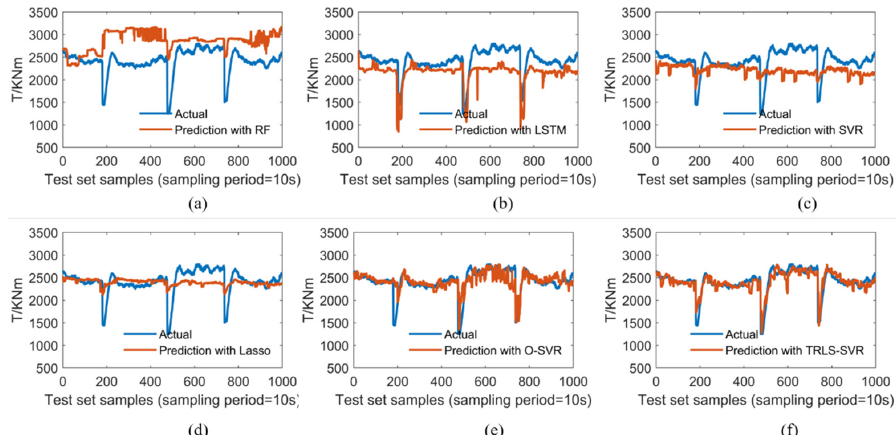
Figure 9. Comparisons between real and predicted cutterhead torque for dataset 5. ( a ) Prediction result of RF. ( b ) Prediction result of LSTM. ( c ) Prediction result of SVR. ( d ) Prediction result of Lasso. ( e ) Prediction result of OSVR. ( f ) Prediction result of TRLS-SVR.